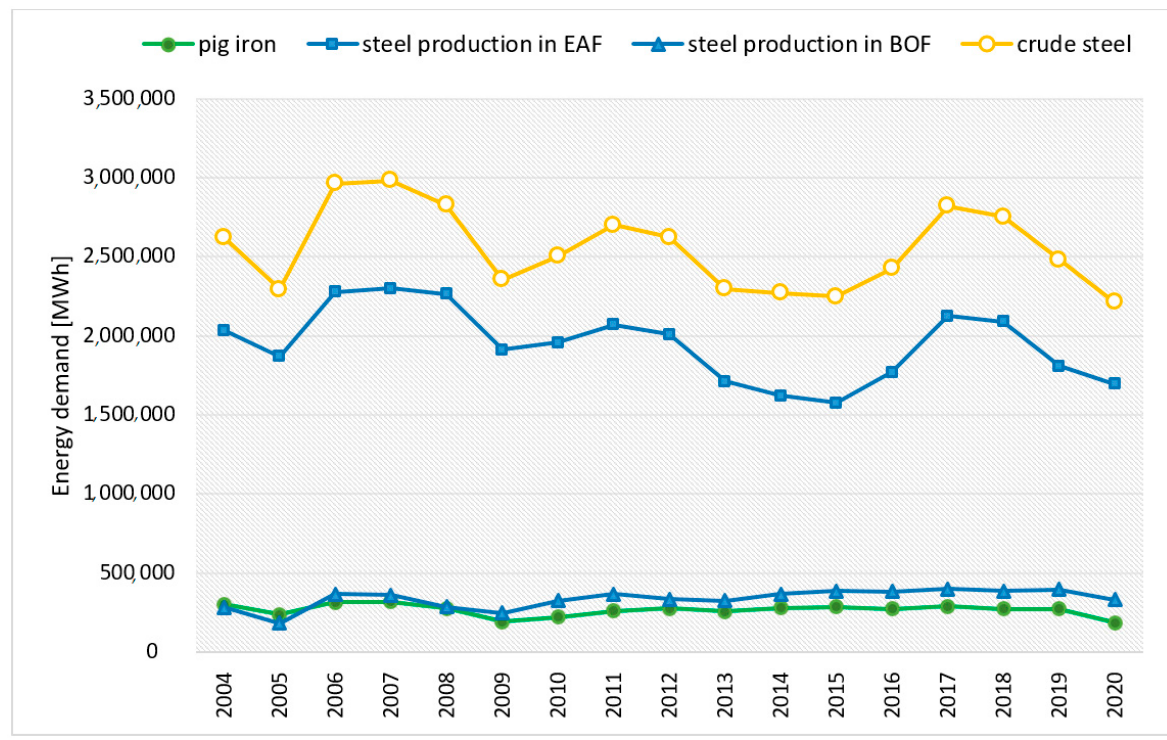
Figure 13. Total energy demand in all metallurgical processes in Poland from 2004 to 2020. Source: Own elaboration. Total energy intensity for the category: crude steel is the sum of energy intensity for production of pig iron with BOF and EAF.